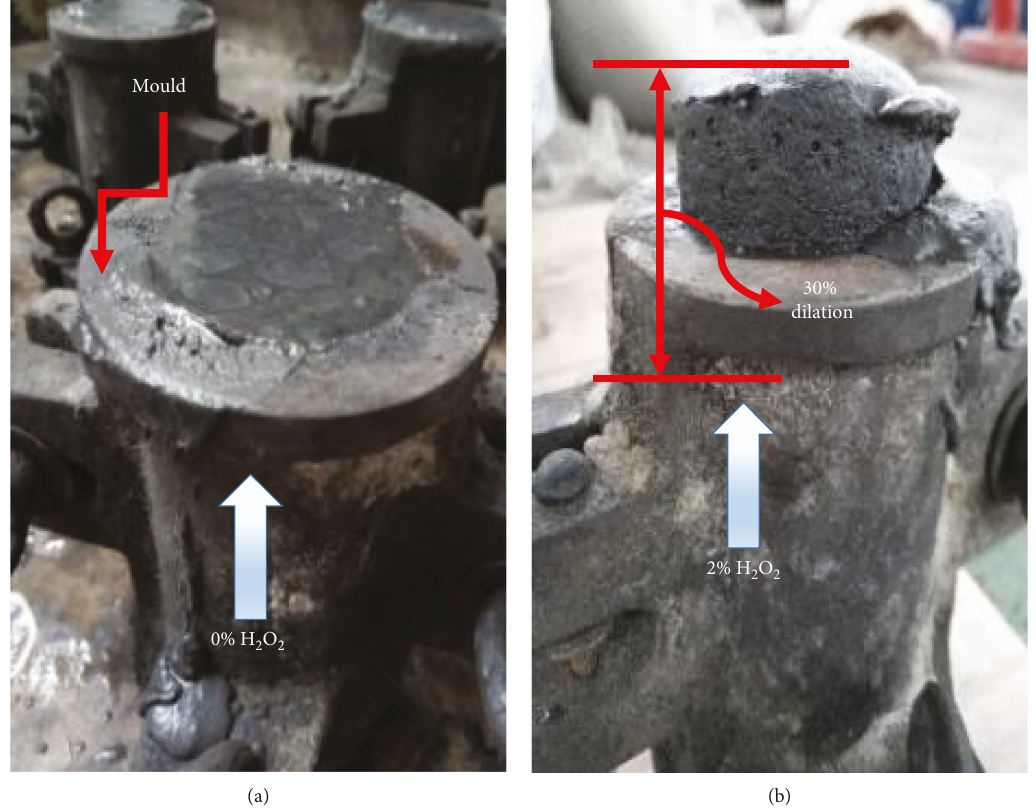
Figure 3: Swelling behaviour of rock-like specimens made with di ff erent hydrogen peroxide contents: (a) specimen without expansion ( H O = 0 %, m = 1 ); (b) specimen with expansion of 30% ( H 2 2